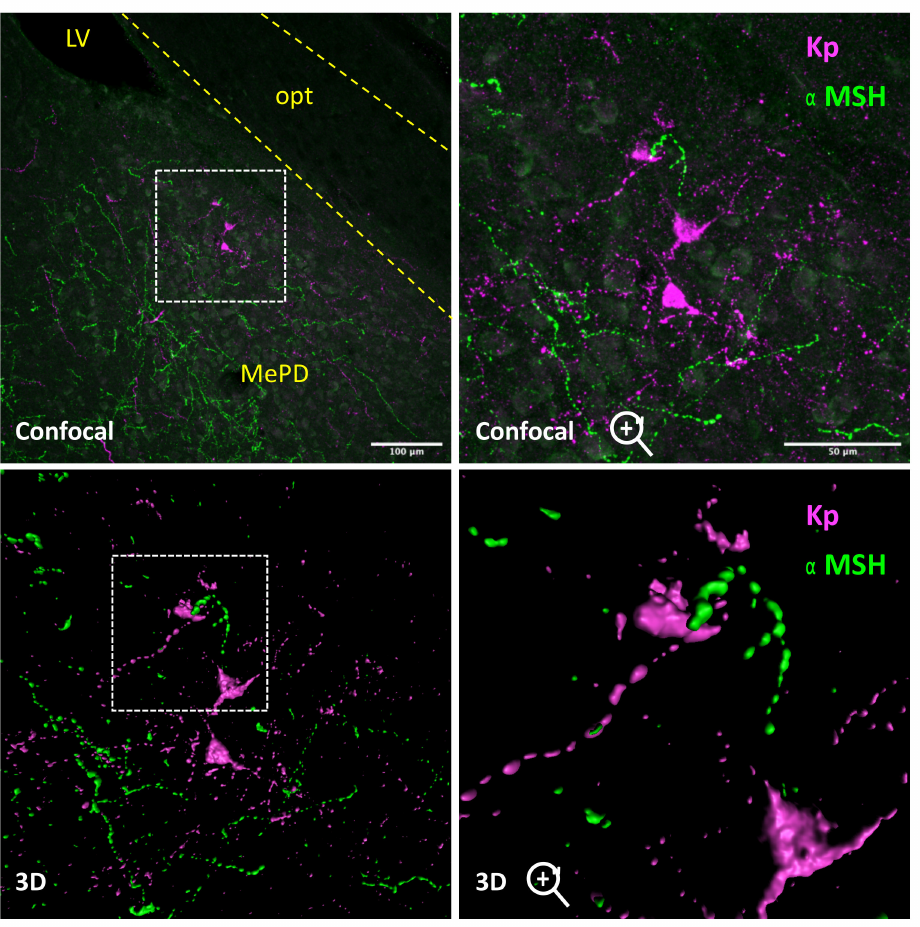
Figure 1. Rat amygdala Kiss1 neurons receive melanocortin inputs. Confocal images and 3D reconstructions of amygdala Kiss1 neurons (magenta) receiving α -MSH (green) appositions. Coronal section of an adult male rat at bregma level—3.60 mm. Materials (antibodies) and methods are described in detail elsewhere [32]. LV = Lateral ventricle; opt = Optic track; MePD = Postero-dorsal area of the medial amygdala